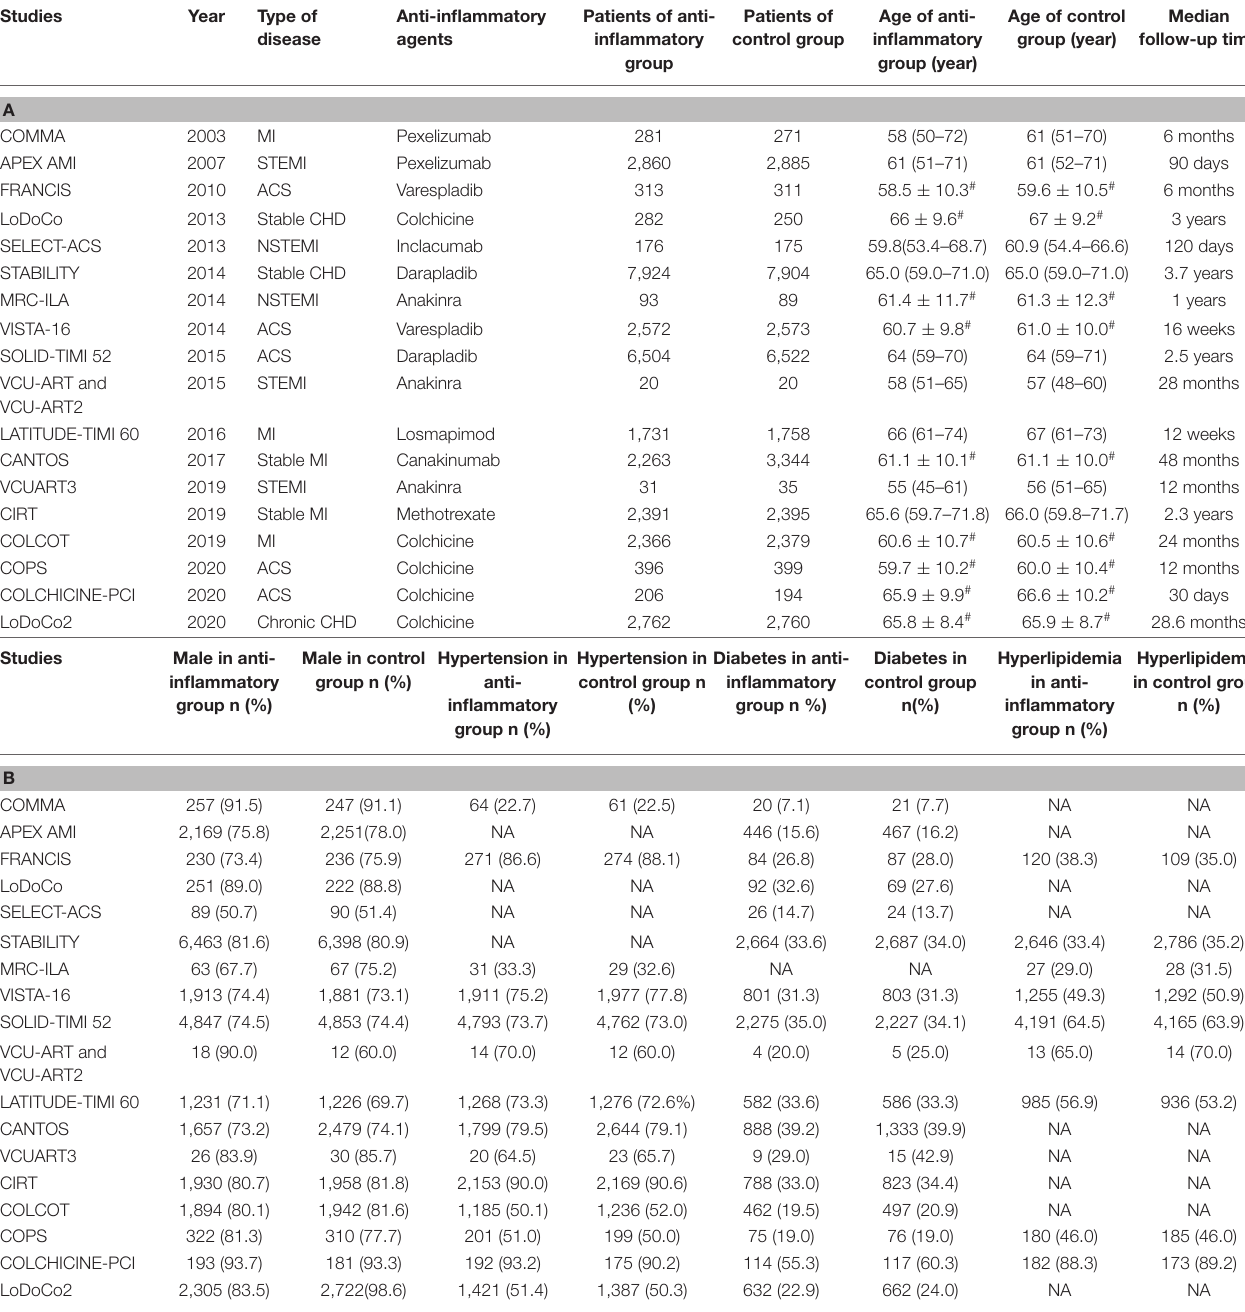
TABLE 1 | Characteristics of the included patients with